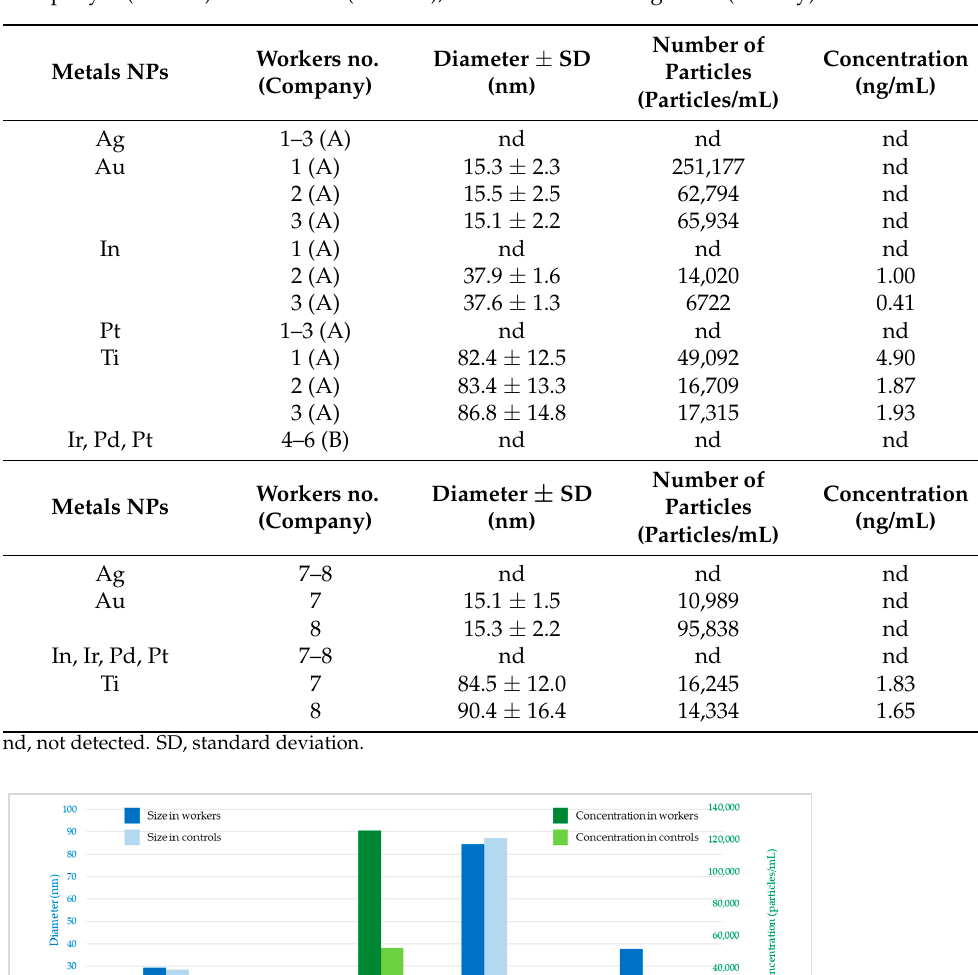
Figure 4. Workers urinary excretion profile of Ag nanoparticles (NPs) during one working week (1st–4th day). Table 4. Analysis of metal nanoparticles (NPs) in blood of workers from Company A (no. 1–3), Company B (no. 4–6) and controls (No. 7–8), at the end of working week (4th day).